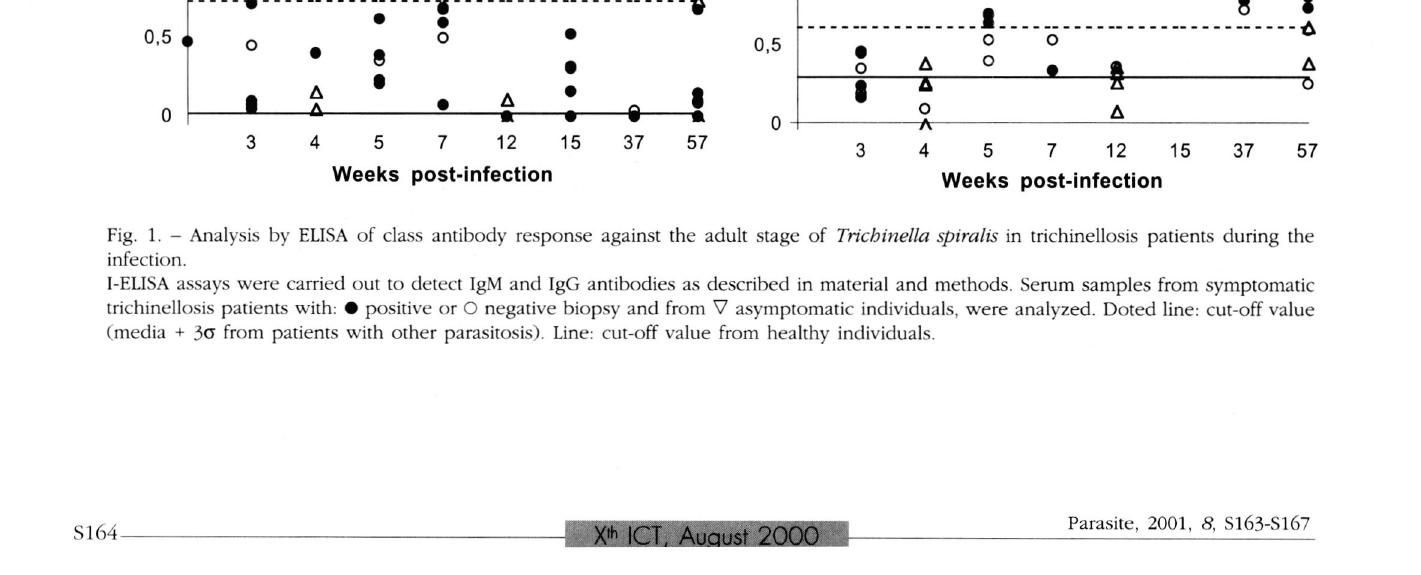
S164 Xth ICT, Auqust 2 0 00 Parasite, 2001, 8,